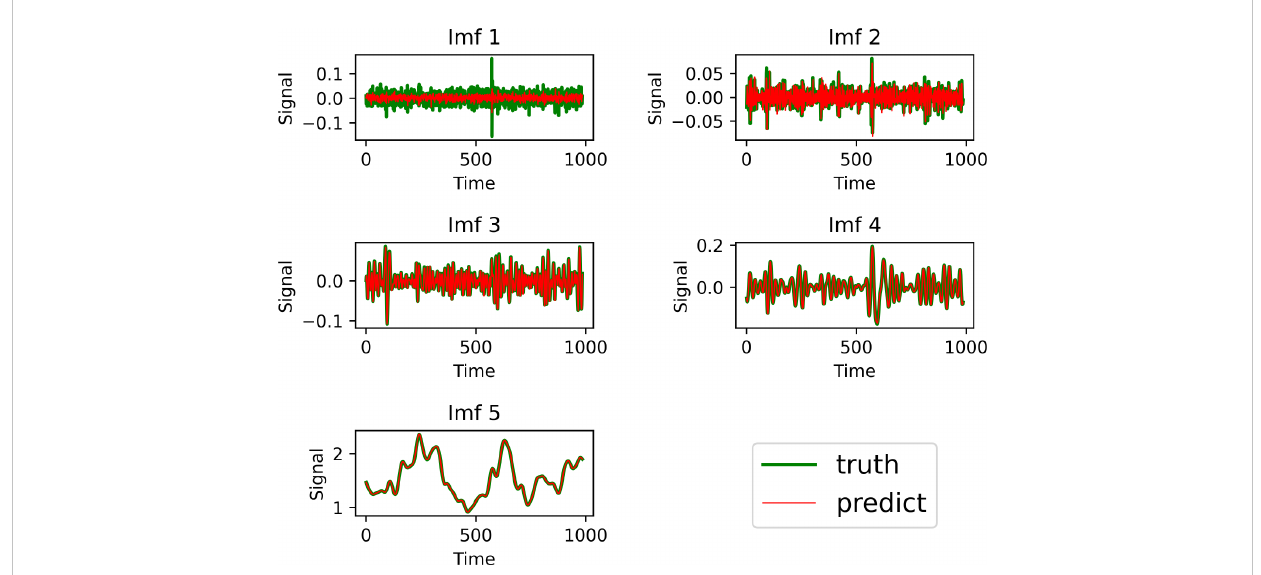
FIGURE 9 Prediction effect of the proposed model for each component decomposed by the EEMD